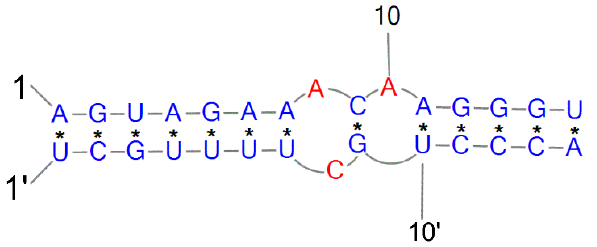
Figure 4. Secondary structure of influenza A virus panhandle. Blue and red letter colors mark paired and unpaired nucleotides, respectively.